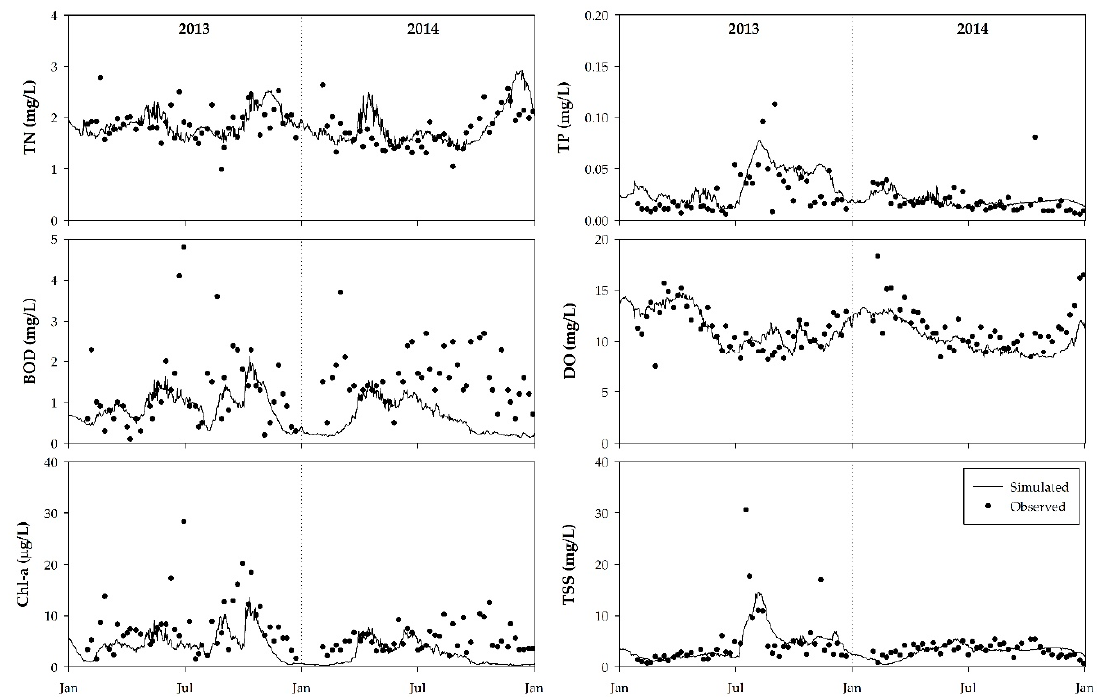
Figure 5. Comparison of observed and simulated water quality for calibration (2013) and verification (2014) at St. 1.